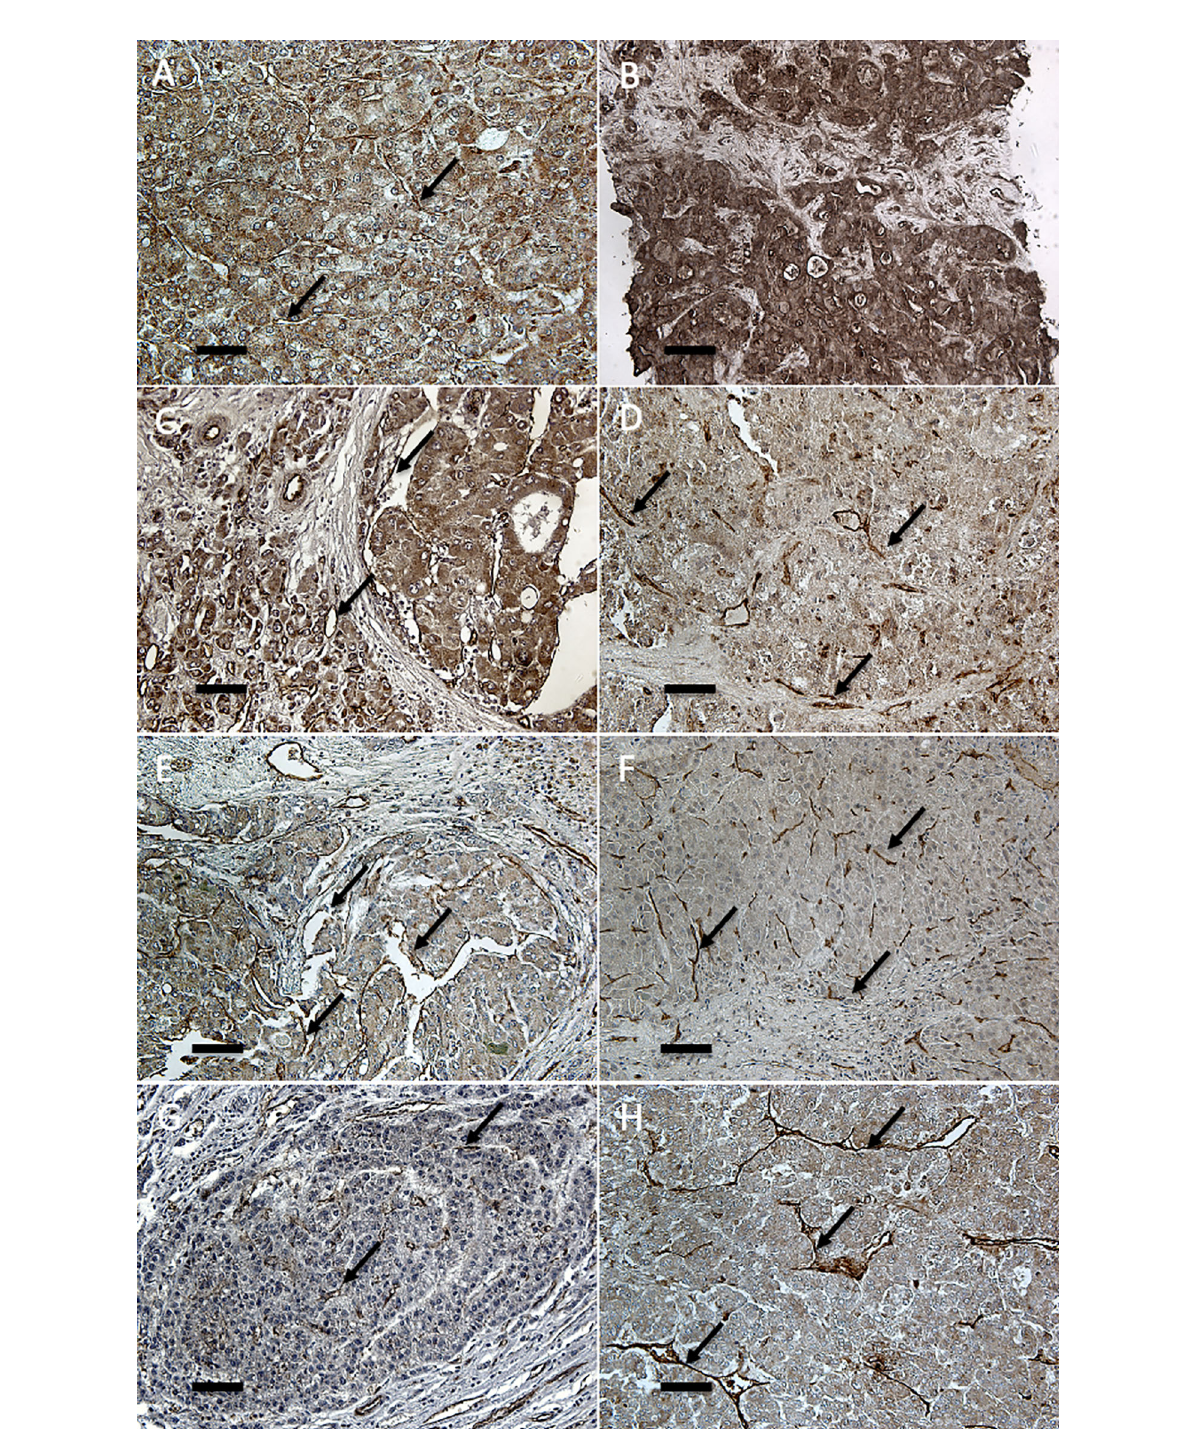
FIGURE 1 Immunohistochemical analysis of angiopoietin-2 in endothelia of primary and recurrent HCCs after LT. Immunostaining for angiopoietin-2 (20×) shows marked cytoplasmic and vascular endothelial positivity both in primary HCCs at explant (A, C, E, G) and in the respective recurrent tumors ( B : liver; D : peritoneum; F : lung; H : kidney). Endothelial and parenchymal angiopoietin-2 expression in hepatic and extra-hepatic recurrent HCCs is more marked than in the corresponding primary tumor. Arrows indicate representative endothelial localization (scale bar: 6.7 m